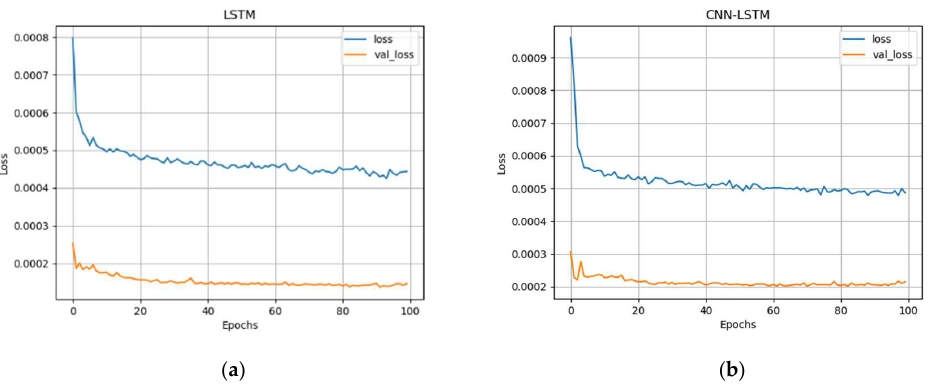
Figure 7. Comparison of training loss and validation loss of ( a ) long short-term memory (LSTM) and ( b ) CNN–LSTM model.